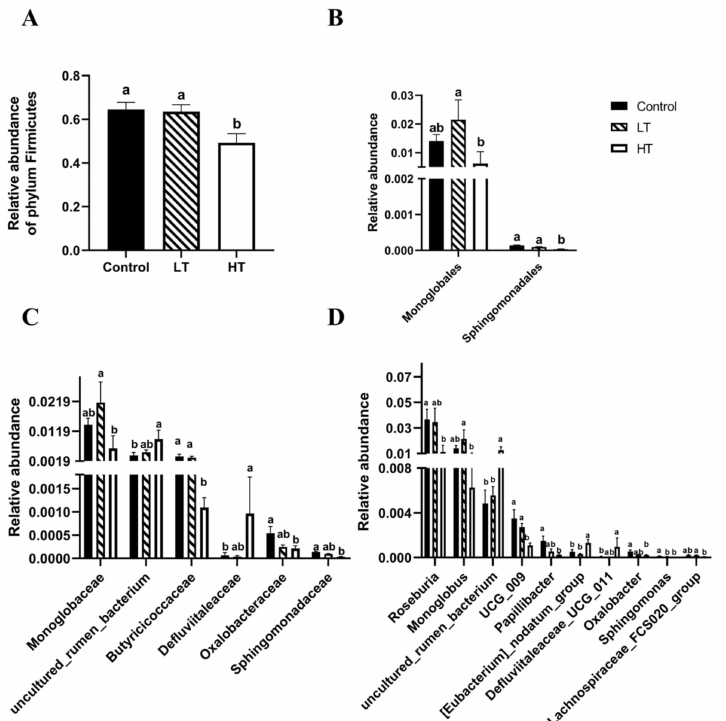
Figure 6. Effect of TA on the relative abundance of colonic microbial taxa of Brandt’s voles. ( A ) phy- lum level; ( B ) order level; ( C ) family level; ( D ) genus level. Control, 0 mg • kg − 1 d − 1 TA; LT, ( p < 0.05). Data are presented as mean ± SEM, n =